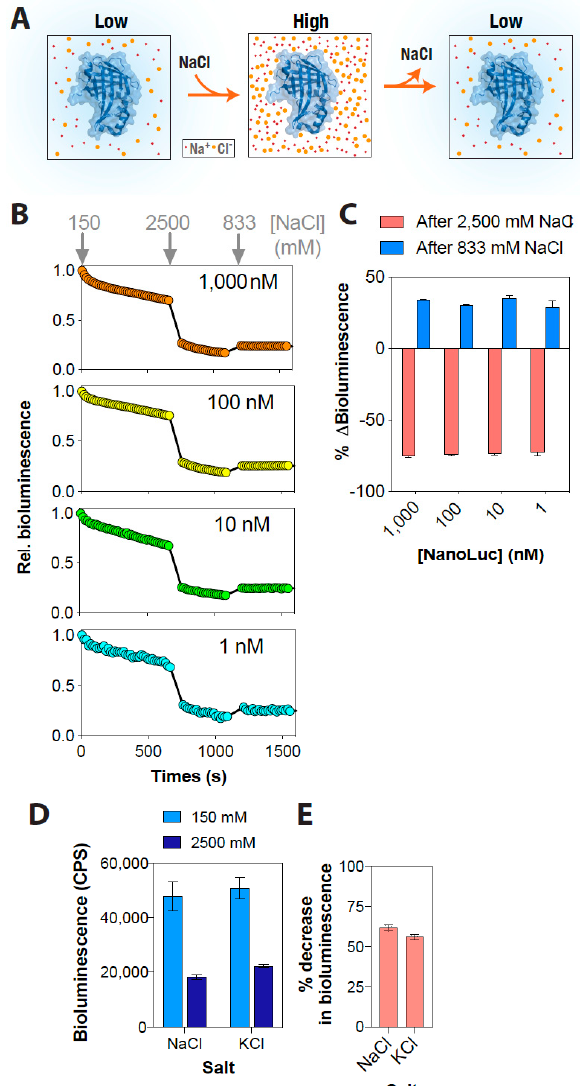
Figure 2. The effect of NaCl on NanoLuc activity is reversible. ( A ) Schematic representation showing the reversible effect of NaCl on NanoLuc bioluminescence activity. ( B ) Graph showing relative bioluminescence of indicated NanoLuc concentrations as a function of time at 150 mM NaCl, which was then increased to 2500 mM and then reversed back to 833 mM. ( C ) Graph showing the percentage change in NanoLuc bioluminescence with consecutive increases and decreases in NaCl concentration. ( D ) Graph comparing NanoLuc bioluminescence at the indicated concentrations of NaCl and KCl. ( E ) Graph showing percentage decrease in NanoLuc bioluminescence with increasing salt concentration as indicated in ( D ). Data shown are mean ± standard deviation (SD) of 5 measurements from a representative experiment.